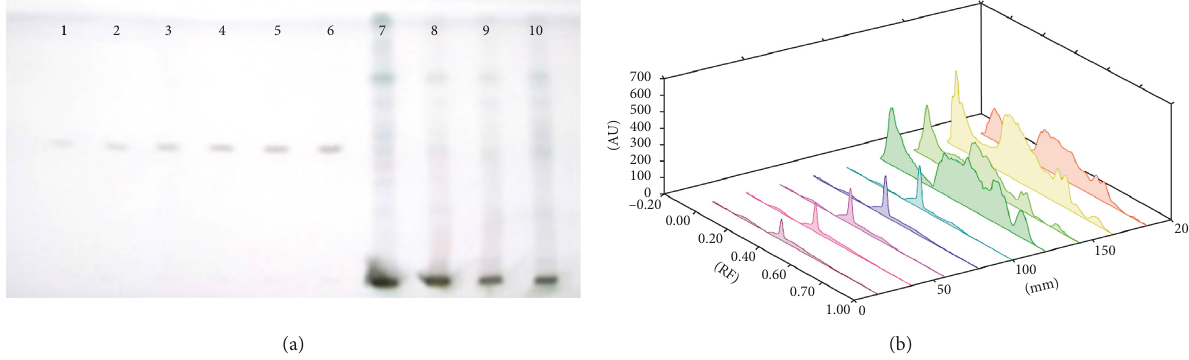
Figure 7: (a) HPTLC fingerprint profile of withanolide B (tracks 1–6) in fruit (track 7); leaf (track 8); stem (track 9); and root (track 10) of S. xanthocarpum ; (b) 3D view of densitogram at 530nm. Table 2: Data showing different parameters analyzed for the reference compounds during the present study by using HPTLC.